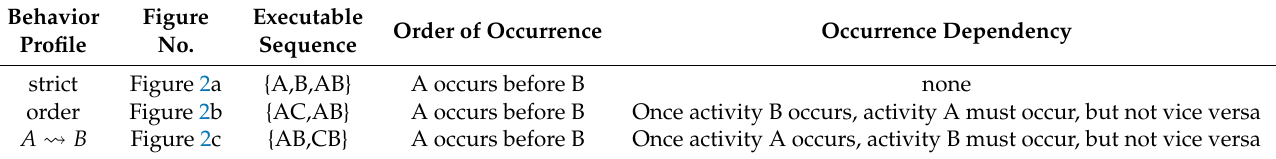
Figure 2. An example of the strict order relation. Table 1. The relationship between activity A and activity B shown in Figure 2.